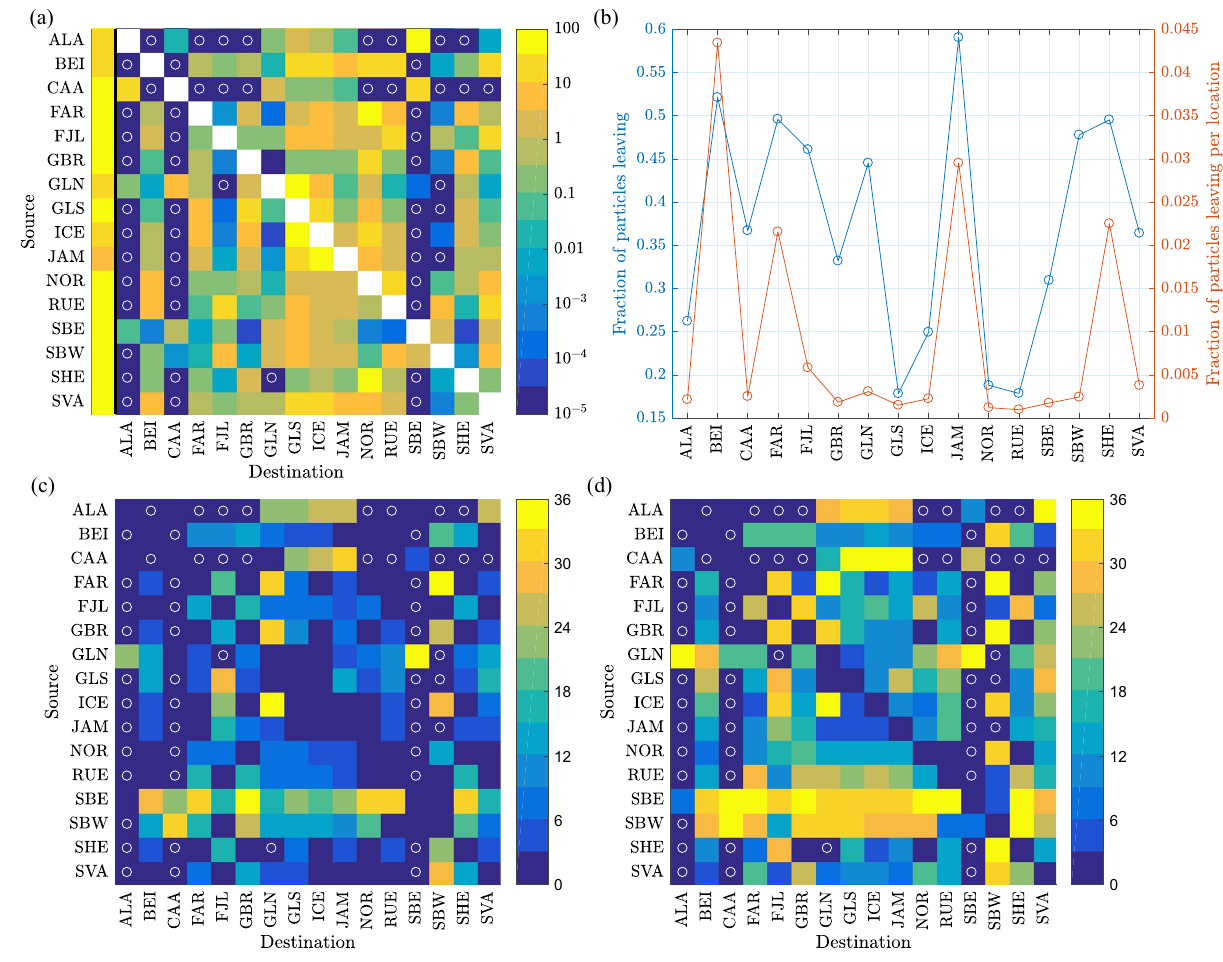
Figure 3. Statistics of transport connections between the 16 coastal regions in the area of study. ( a ): A connection matrix, showing the fraction of drifters (in percent) from a given source region (rows) reaching a given destination (columns). The first, unlabelled column represents particles that drifted out of the domain of study or are still afloat after 3 years. The sum of values in each row equals 100%. White circles mark cells with the value of zero. ( b ): Fraction of all particles released in a given region in the period 1993–2017 that escaped that region (left axis: in percent; right axis: divided by the number N r of release locations, see Table 1). ( c , d ): The minimum and median, respectively, time in months required for a particle from a given source region (rows) to reach a given destination